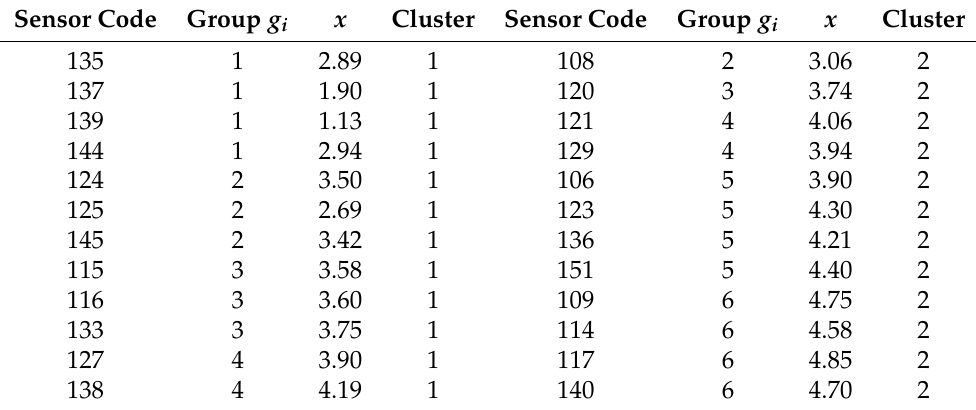
Figure 6. Calculated static map (basic noise map) for all roads belonging to Milan urban Zone 9 [86] (see Figure 5). The colors represent the Leq values, according to the scale indicated in the inset, obtained during the ‘rush hour’ hour (8:00–9:00) a.m. The latter is the hour with the highest traffic flow in the day, where the basic noise map is most accurate. The black triangles give the position of the 24 Dynamap noise sensors (numbered in the range 106–151, see Tables 2 and 3), and the yellow circles the locations of the test measurements for validation (numbered 1–21, see Table 4). Table 3. Monitoring sensors information: Code, group membership, non-acoustic parameter x = log ( T T ) , and cluster membership. The cluster compositions are: (Cluster 1) 12 sensors; (Cluster 2) 12 sensors [91]. Note that sensors in groups: g 2 , g 3 , g 4 , are shared among the two